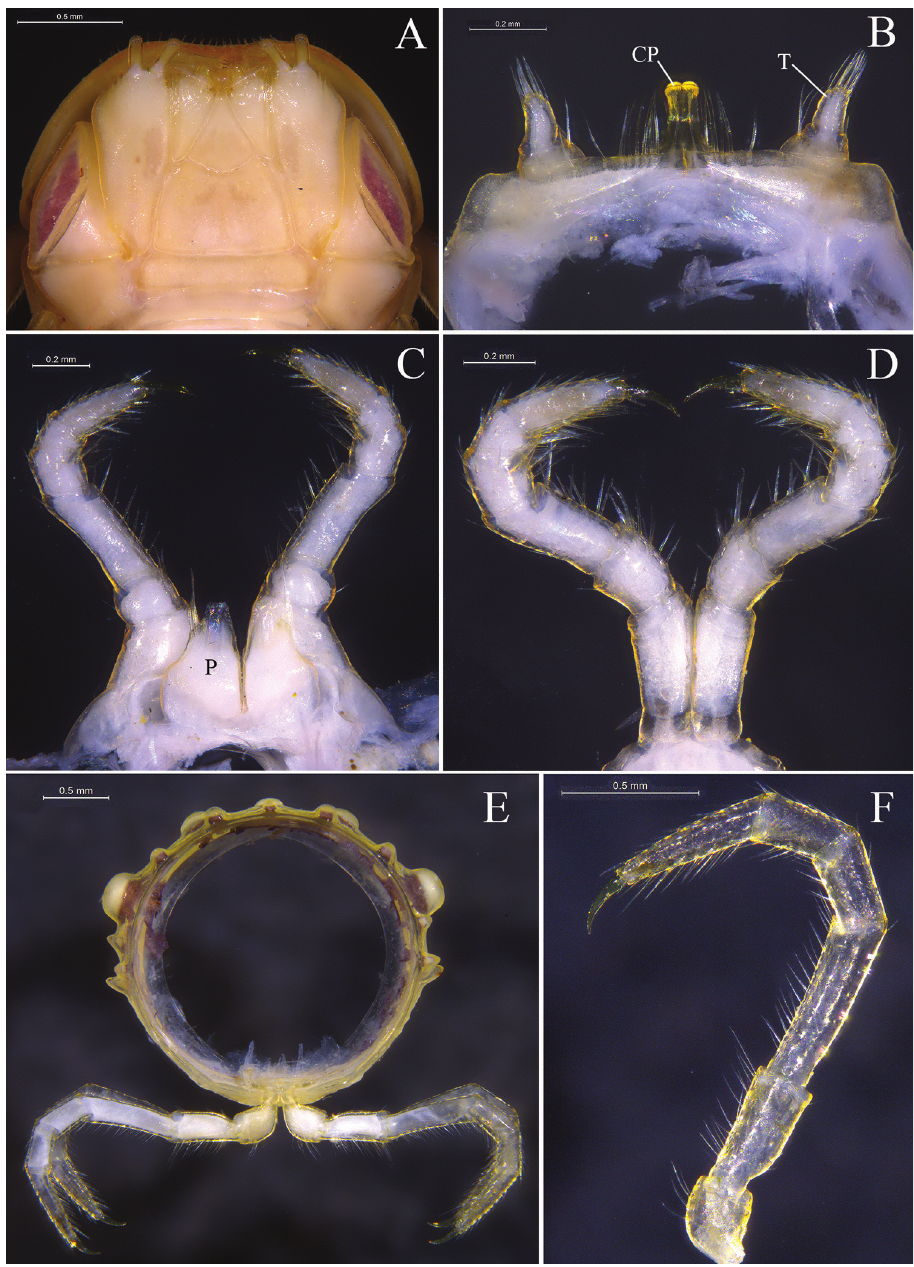
Figure 3. Glyphiulus foetidus sp. n., holotype. A gnathochilarium, ventral view B legs I, anterior view C legs II, caudal view D legs III, caudal view E cross-section of a midbody segment, caudal view F midbody leg, anterior view. Abbreviations: CP = coxal process; P = penes; T =